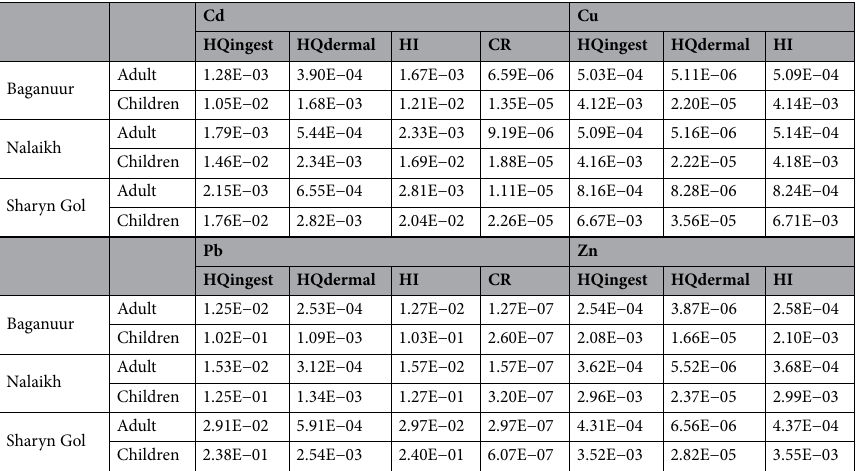
Table 5. Average values of human health risk assessment via potential non-carcinogenic (HI) and carcinogenic risk (CR) following different exposure pathways in the coal mining